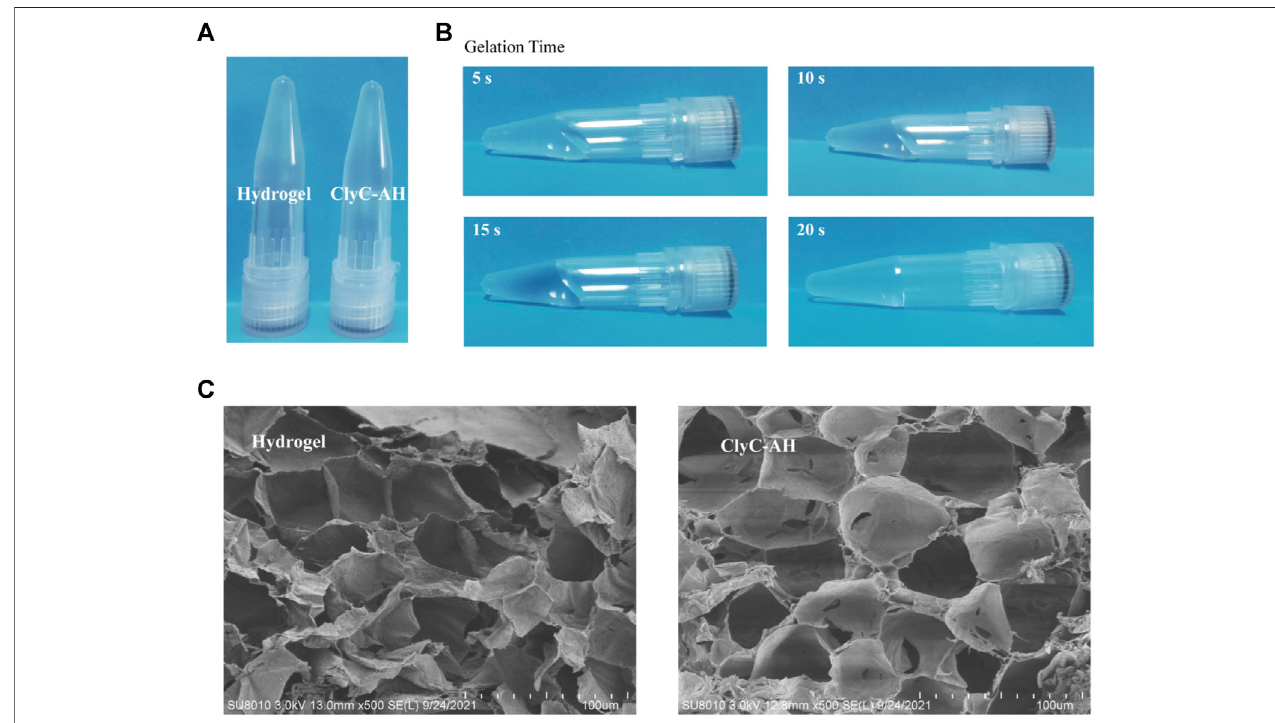
FIGURE2| CharacterizationoftheClyC-AH. (A) ImagesofthehydrogelandClyC-AHatroomtemperature; (B) Gelationtimeshowingthesolution-geltransitionof ClyC-AH; (C) Surface morphologies of hydrogel and ClyC-AH by SEM.